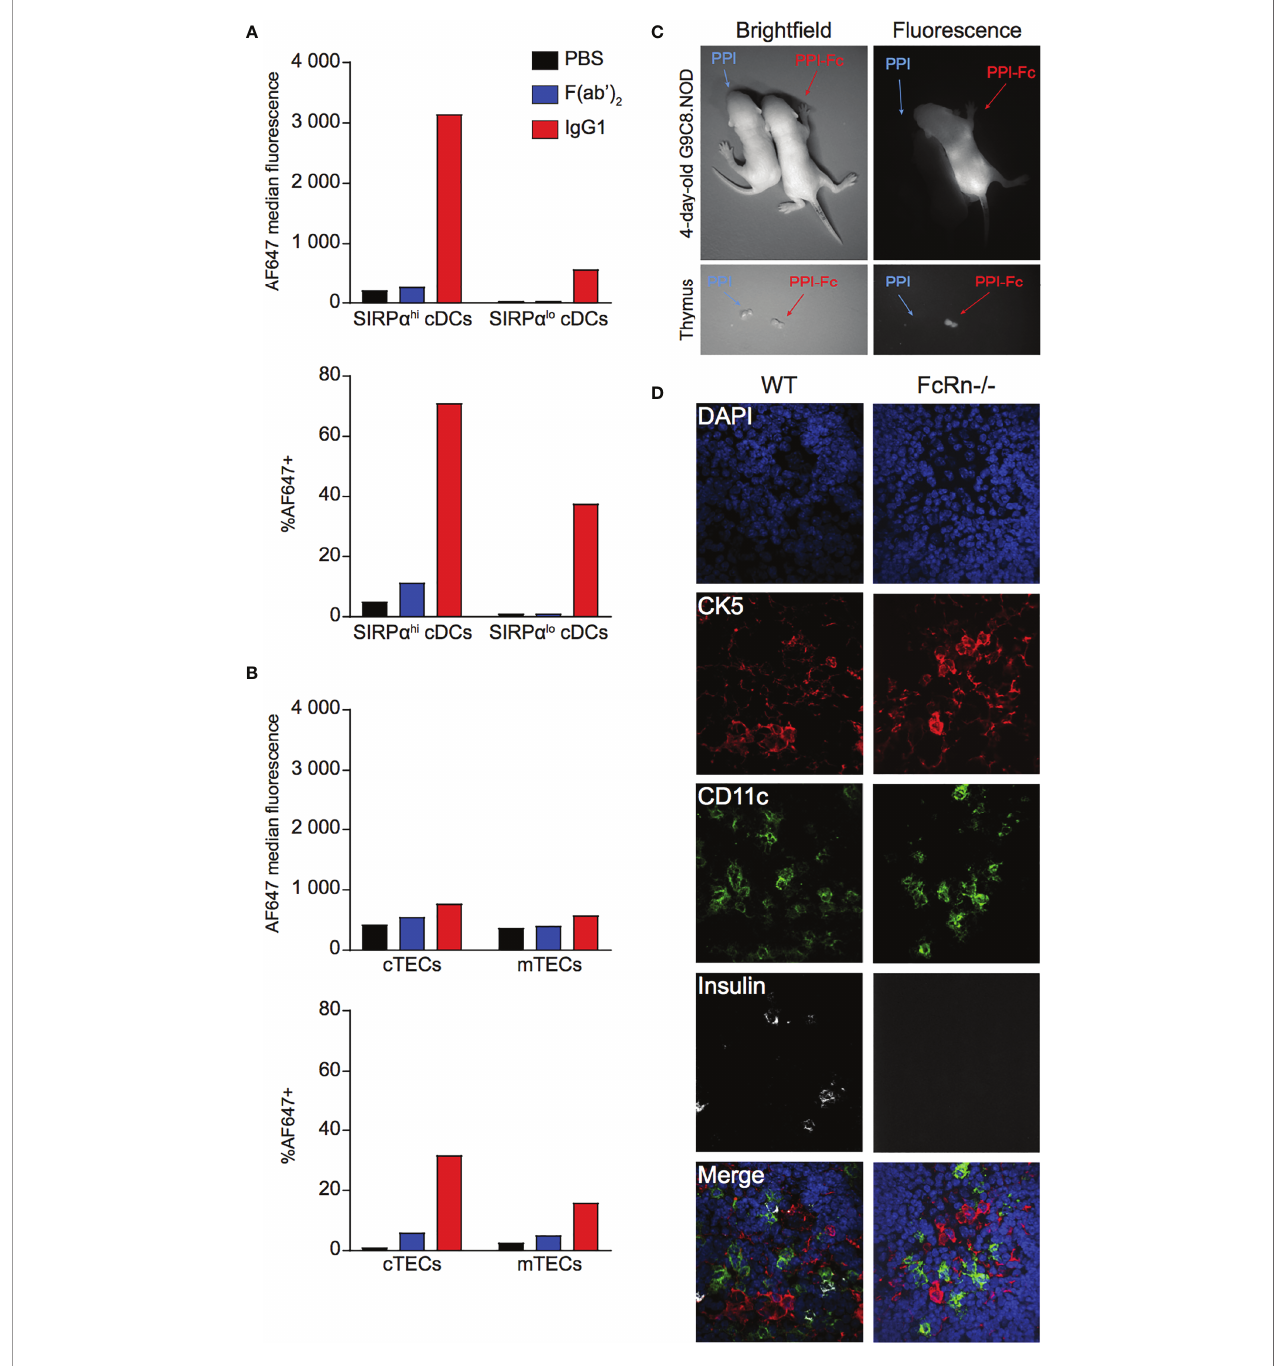
FIGURE 5 | Oral PPI-Fc reaches the thymus mainly through ferrying by migratory SIRP a hi cDCs. (A, B) Five-day-old G9C8.NOD mice were force-fed with 50 µg AF647-labeled IgG1 (red), F(ab ’ ) 2 (blue), or PBS (black). Thymi from 3 mice/group were pooled and cells were magnetically enriched for CD11c + DCs (A) and EpCAM + TECs (B) before fl ow cytometry (see Supplementary Figure 5 for details). Protein uptake (AF647 median fl uorescence and percentage of AF647 + cells) was analyzed in the indicated DC and TEC subsets. (C) Ex-vivo imaging of the whole body (top) and thymus (bottom) of 1-day-old G9C8.NOD mice 72 h after oral administration of 50 µg AF680-labeled PPI-Fc or PPI (day 4 of life). (D) Confocal images of thymic sections recovered from WT G9C8.NOD and FcRn -/- .B6 mice 24 h after oral administration of fl uorescent PPI-Fc. Sections were stained for insulin (white), CD11c (green) and cytokeratin 5 (CK5, red), with nuclei counterstained with DAPI